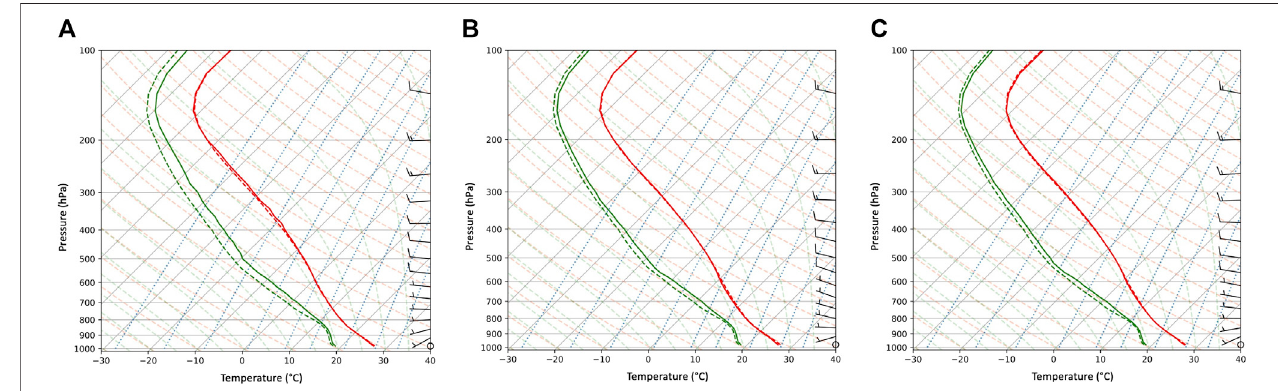
FIGURE 11 | Composite soundings corresponding to (A) the Debbage and Shepherd (2015) method of de fi ning URDs, (B) the Mote et al. (2007) method of de fi ning URDs, and (C) the novel method of de fi ning URDs. Each sounding has a set of dashed and solid air temperature (red) and dew point temperature (green) lines. The dashed lines represent the climatological mean sounding for every June – August day during 2002 – 2019, while the solid lines represent only the